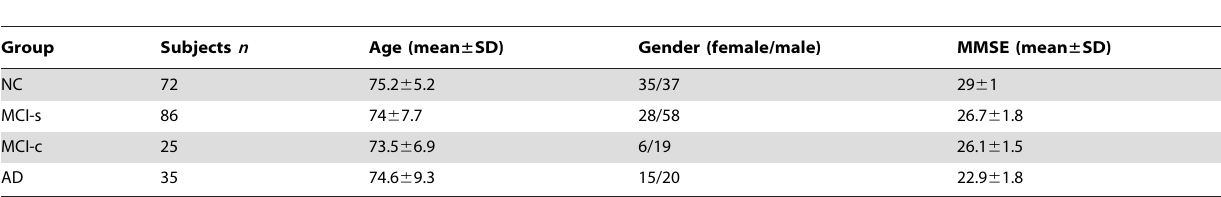
Table 1. Demographic information for each of the diagnosis groups (normal controls (NC), mild cognitive impairment (MCI), and Alzheimer’s disease (AD)) at the baseline.